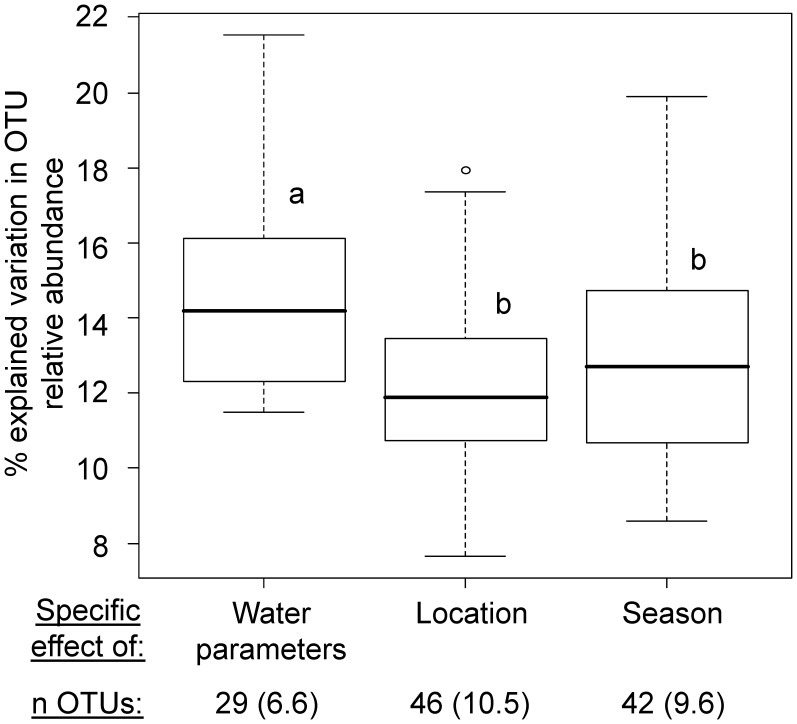
Detecting specialists vs. generalist OTUs by variation partitioning for individual OTUs.The numbers in italics indicate OTU numbers (percentage of the total of 437 OTUs), which variation in relative abundance was purely explained by the corresponding factor on the x-axis as determined by multivariate partial regression analyses, while taking all other factors into account. Different letters indicate significantly different means at p<0.05 (Welch two-sample t-test).